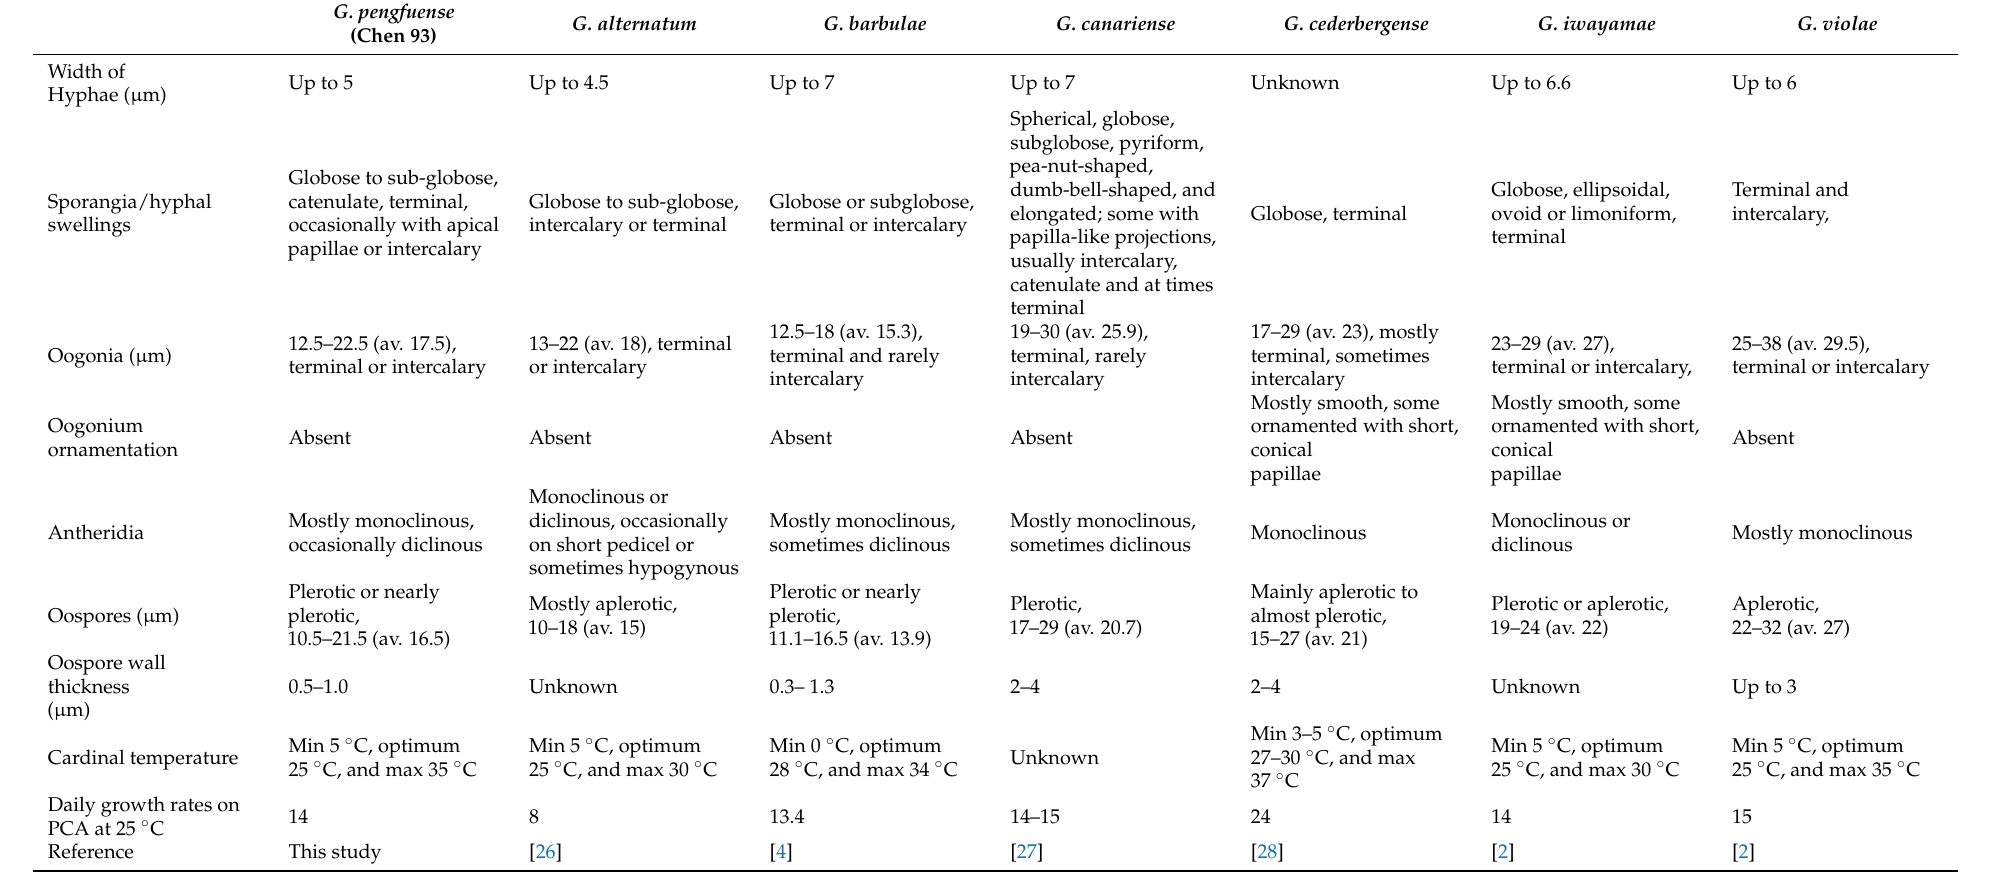
Table 2. Morphological description of Globisporangium pengfuense and the most closely related